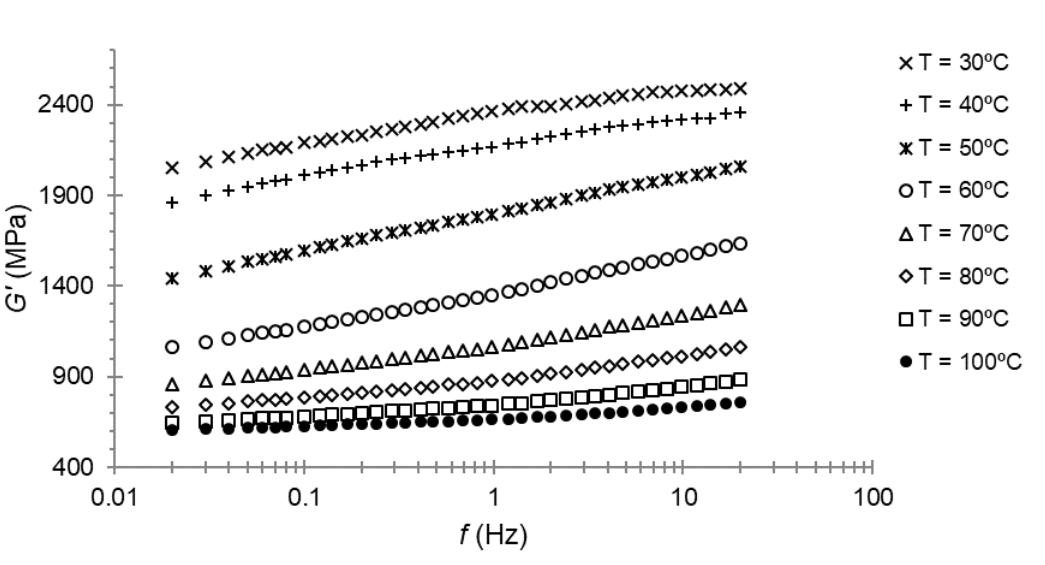
Figure 5. Storage modulus–frequency plot for PA66.